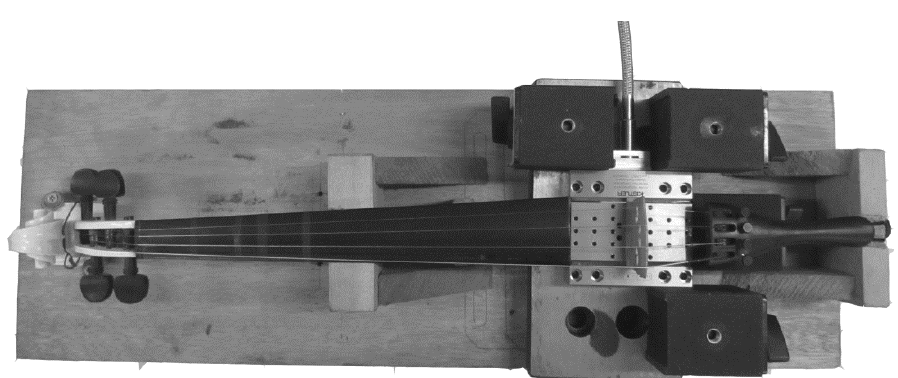
Figure 13. Experimental